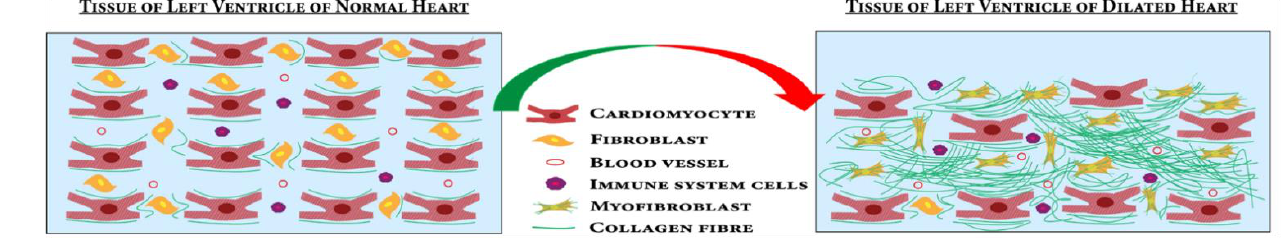
Figure 3. In DCM, cardiomyocytes undergo apoptosis and proliferation of cardiac fibroblasts to myofibroblasts causes fibrosis in the left ventricle of the heart. These processes lead to left ventricle dilation and wall thinning.